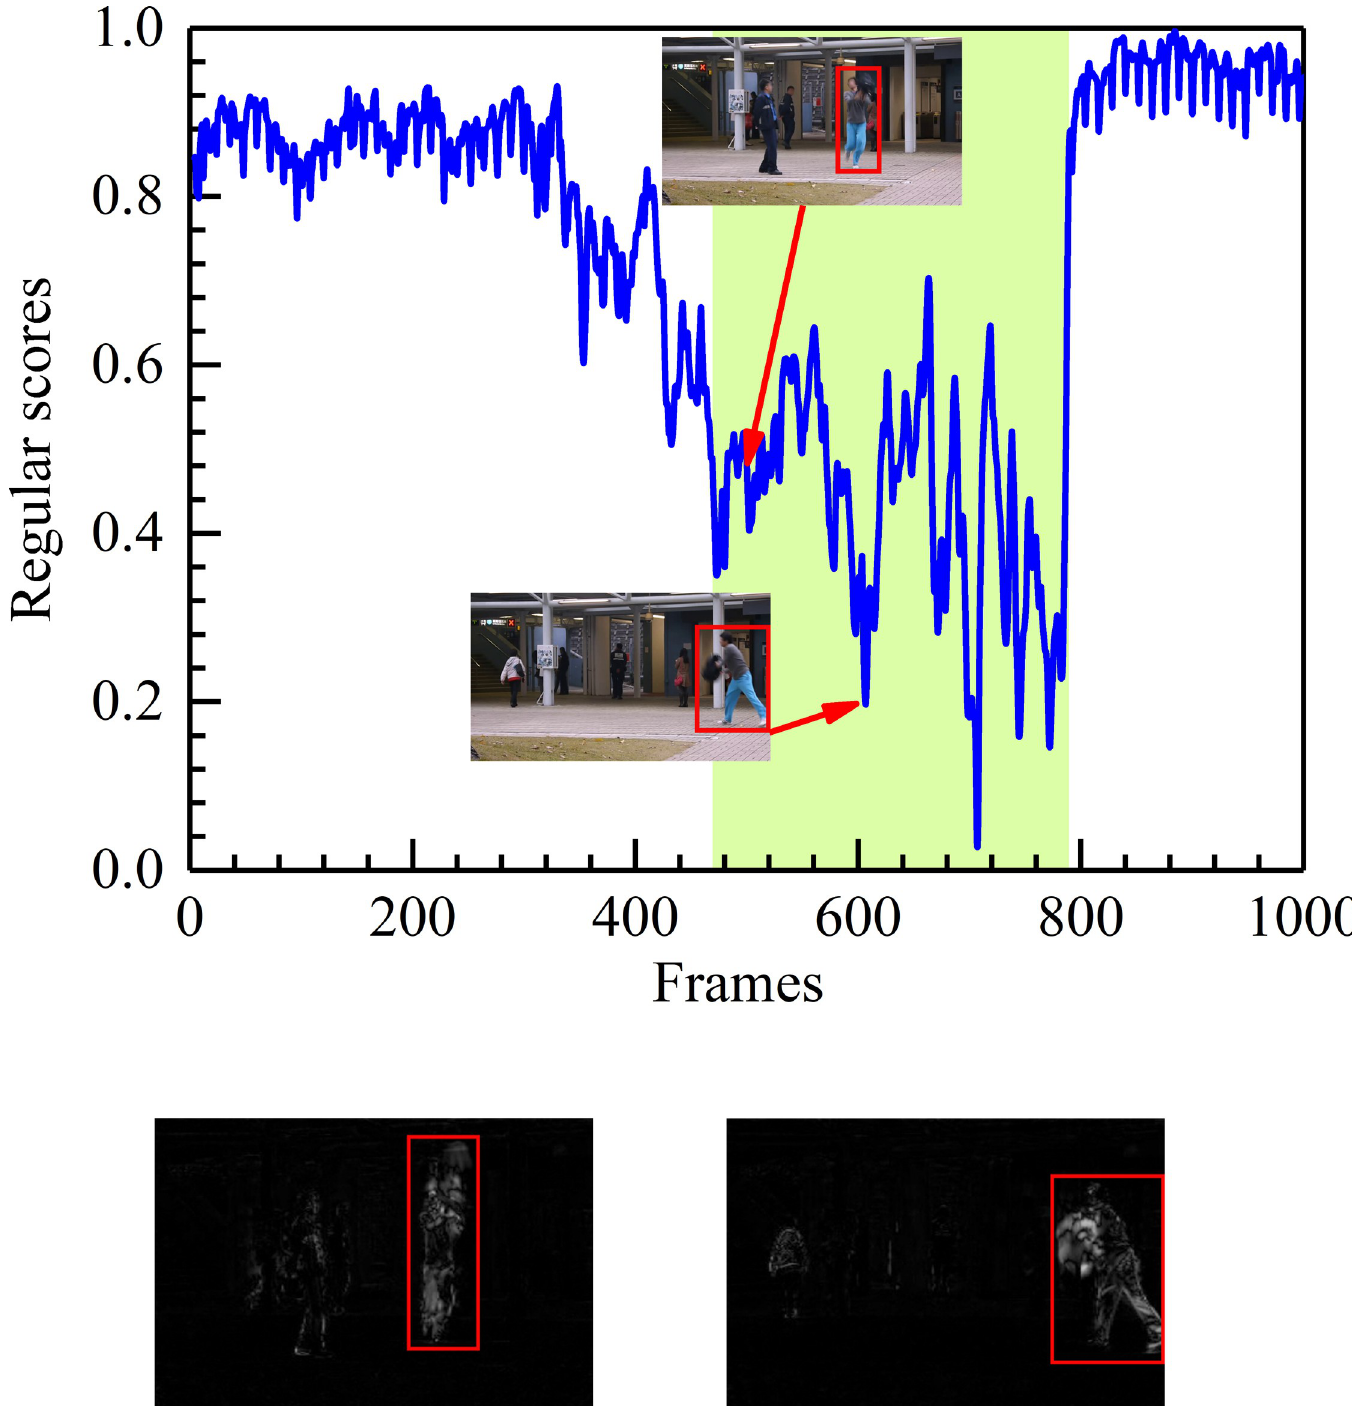
Fig 7. Frame-level evaluation results on the 5th test video of Avenue. (a) Relationship between the test video frames and the regular score. (b) Difference between the ground truth and the corresponding generated frame. https://doi.org/10.1371/journal.pone.0265564.g007 blocks denote the ground truth abnormal region, and the blue line represents the regular score of every frame. Higher regular scores indicate normal events. On the contrary, the lower